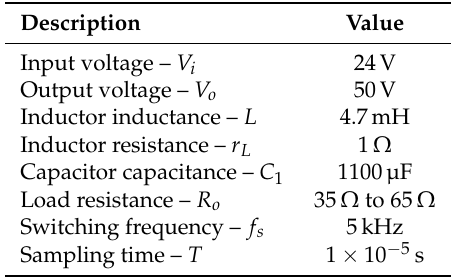
Table 1. Boost converter’s values used in